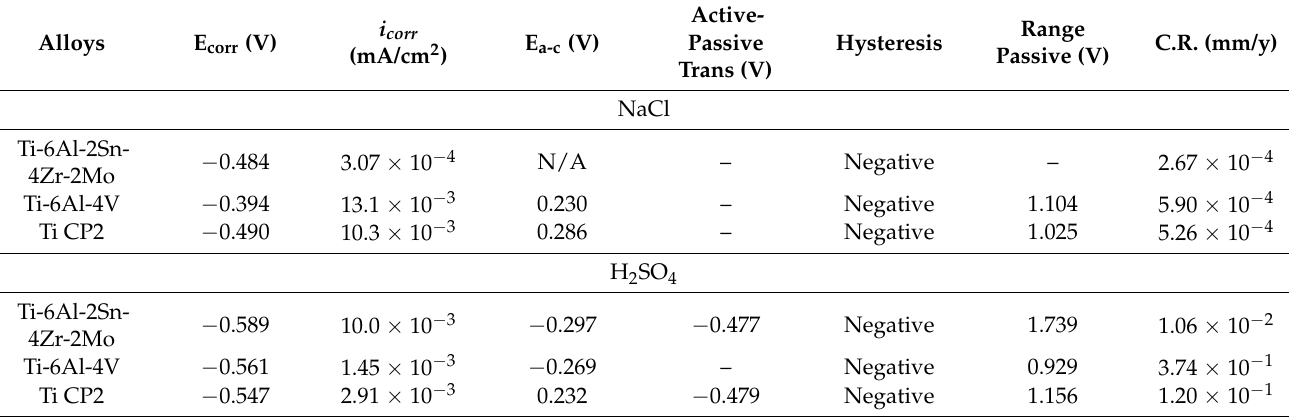
Figure 2. Cyclic potentiodynamic polarization curves of titanium alloys exposed in a 3.5 wt % NaCl solution. Table 2. Cyclic potentiodynamic polarization parameters in titanium alloys, in 3.5 wt % NaCl and H 2 SO 4 solutions.